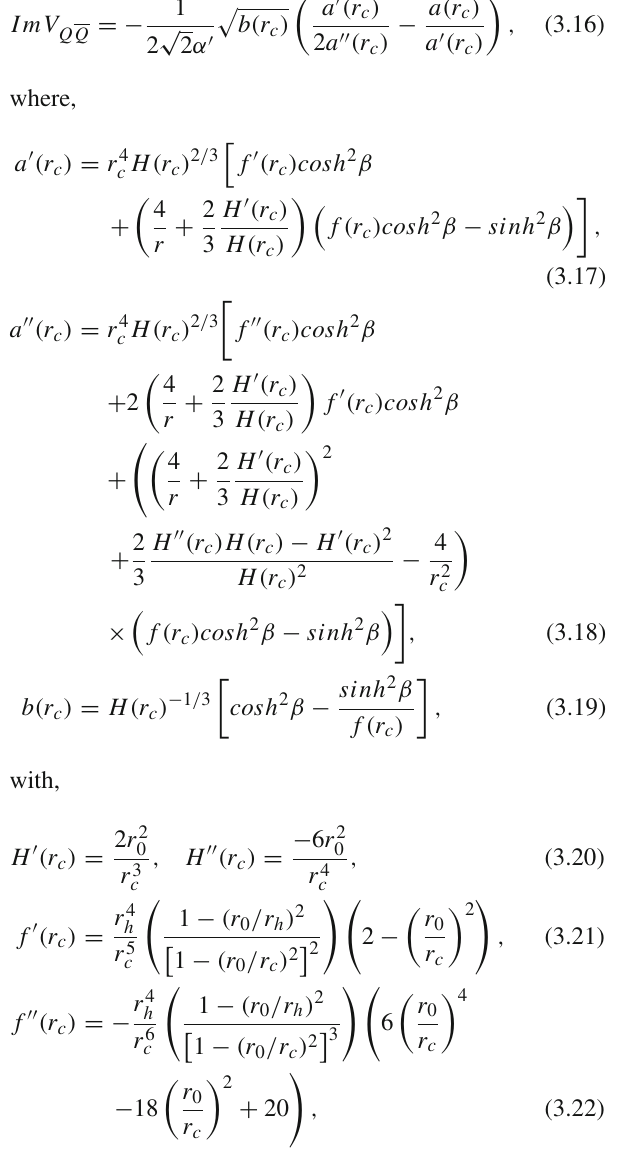
On the other hand, by applying the thermal worldsheet fluctuation method [12] for studying the imaginary part of the heavy quark potential we